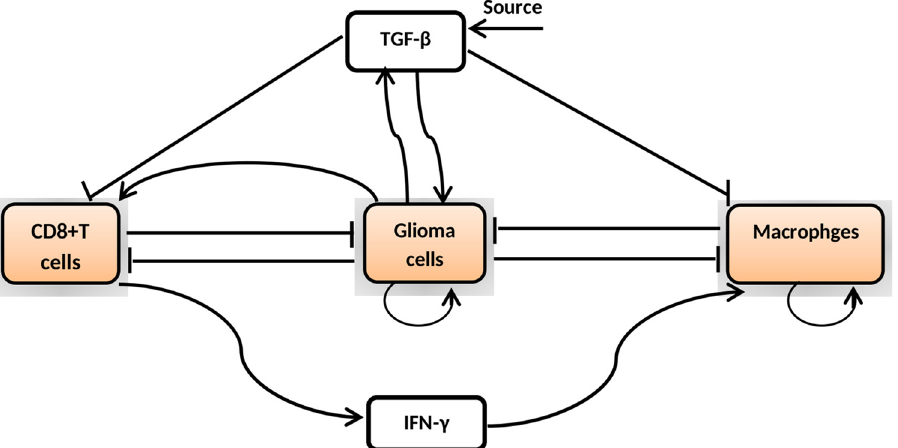
Figure 1. A schematic diagram represents the interaction of cells and cytokines that are used in the model. The model represents cells (colored rectangles) and cytokines (clear rectangles). Sharp arrows indicate proliferation/ activation, blocked arrows indicate killing/blocking/inhibition and round arrows indicate self-proliferation of